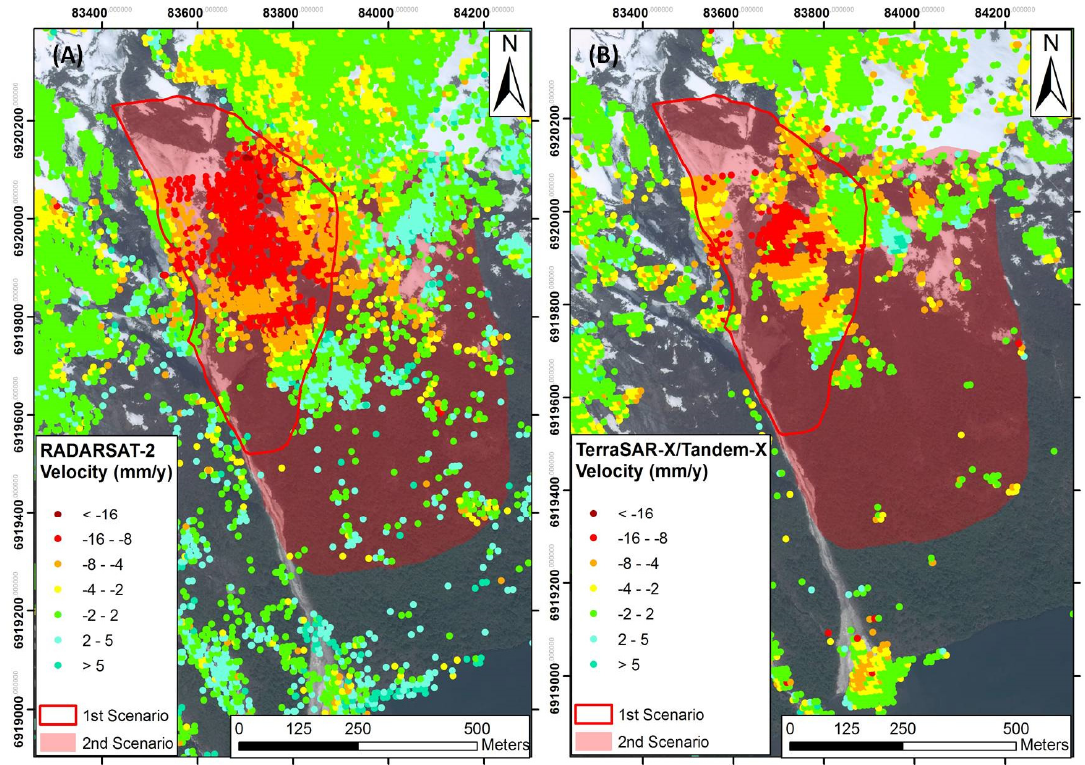
Figure 8. Mean velocities registered by RADARSAT-2 ( A ) and TerraSAR-X/Tandem-X ( B ) between 2010 and 2012 (values detectable on the LOS of the satellites). The red line corresponds to the landslide limit in the most dangerous scenario.